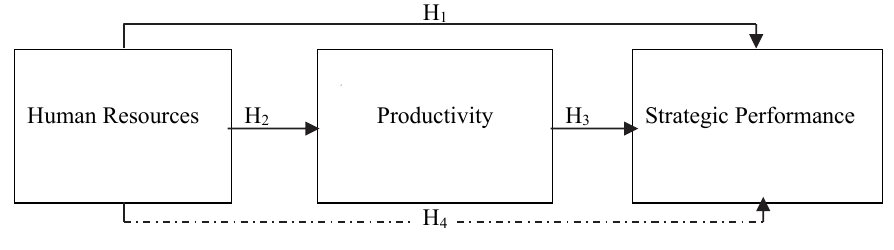
Fig. 1. The proposed